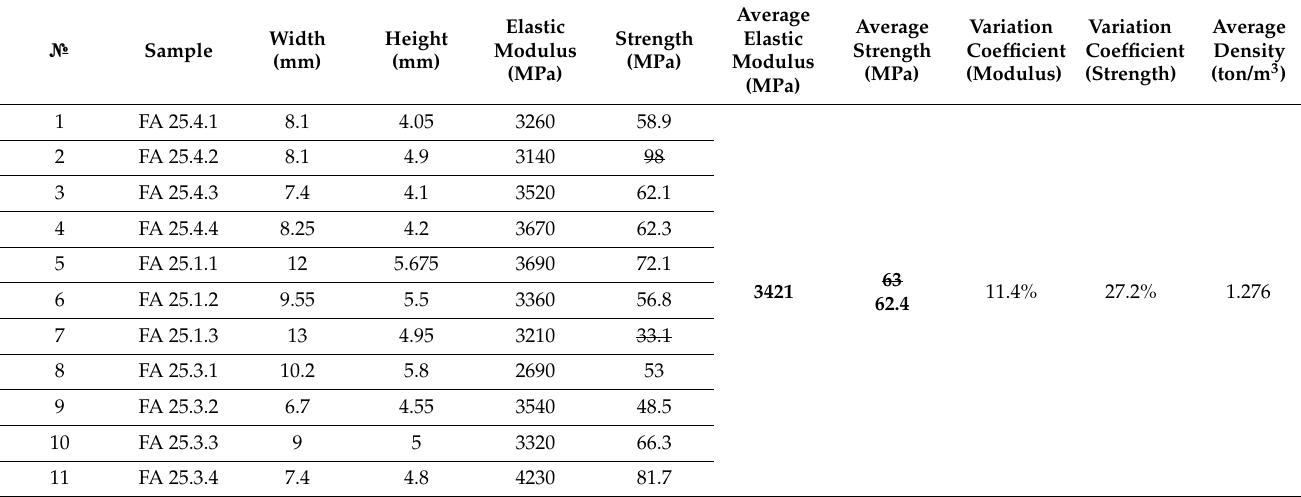
Table A27. Three-point bending test results at 23 ◦ C of filled binder (EP-FA25).